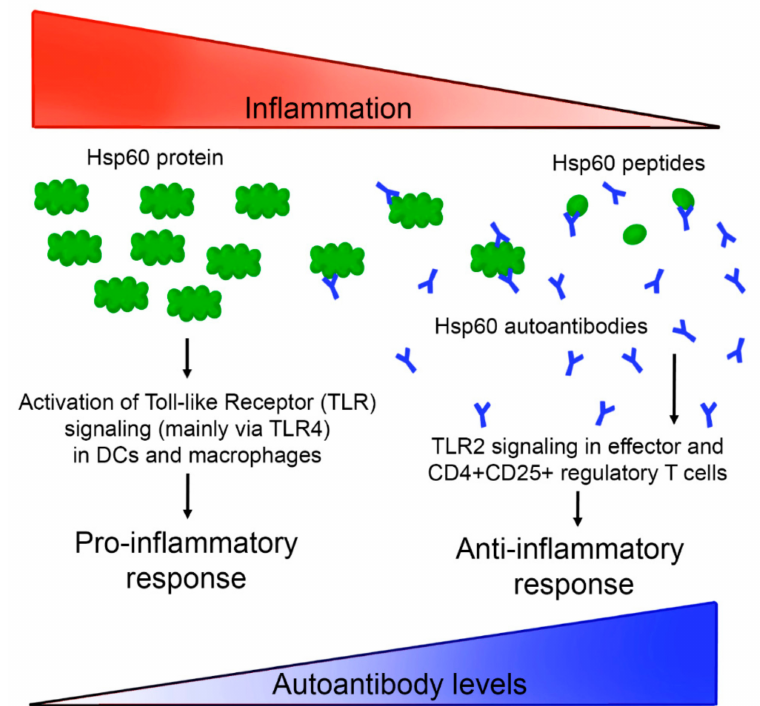
Figure 6. A possible Hsp60 autoantibody regulation system based on a previously described model [30]. High Hsp60 protein levels, related with endogenous proteins and / or similar chaperonins present in microbiota or other pathogens, would activate inflammation pathways, which in turn would induce the production of autoantibodies against Hsp60, neutralizing the antigen, and generating di ff erent peptides that activate an anti-inflammatory